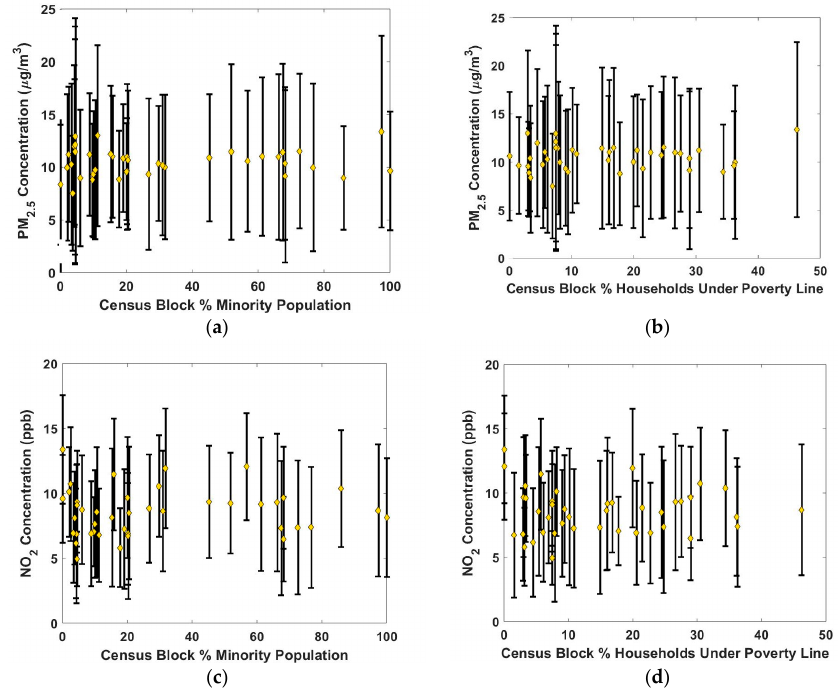
Figure 7. Environmental justice analysis showing mean (yellow diamond) and standard deviation (whiskers) at each site. Site 2 was not included in the PM 2.5 analysis due to the impact of the local restaurant emissions at that site. ( a ) and ( b ) show the lack of correlation between PM 2.5 concentrations and percent of the population who ( a ) belong to a minority group or ( b ) are living below the poverty line. ( c ) and ( d ) similarly show the lack of correlation between NO 2 concentrations and the same two socio-economic variables. Spearman’s rho, a non-parametric measure of rank correlation, can be used to test the relationship between two variables. A Spearman’s rho with an absolute value of less than 0.20 is indicative of very weak correlation between the variables, only above 0.60 is the correlation considered strong. The Spearman’s rho between mean PM 2.5 concentration at a site and percent of the population living below the poverty line in the census block group is 0.05. The Spearman correlation between mean PM 2.5 and percent of the population belonging to a minority group is similarly low (0.01). This means that the relationship between mean PM 2.5 concentration and socioeconomic (EJ) variables cannot be described by a monotonic function; PM 2.5 concentration does not increase with increasing EJ indicators.